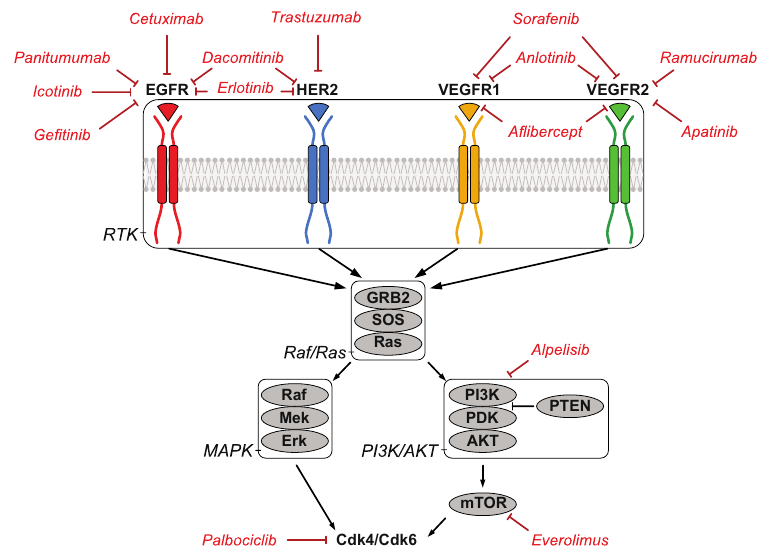
Figure 2. Scheme summarizing the signaling pathways that have been targeted the most frequently in oesophageal cancers. The different targeted therapies used in clinical trials to treat esophageal cancers are shown in red.